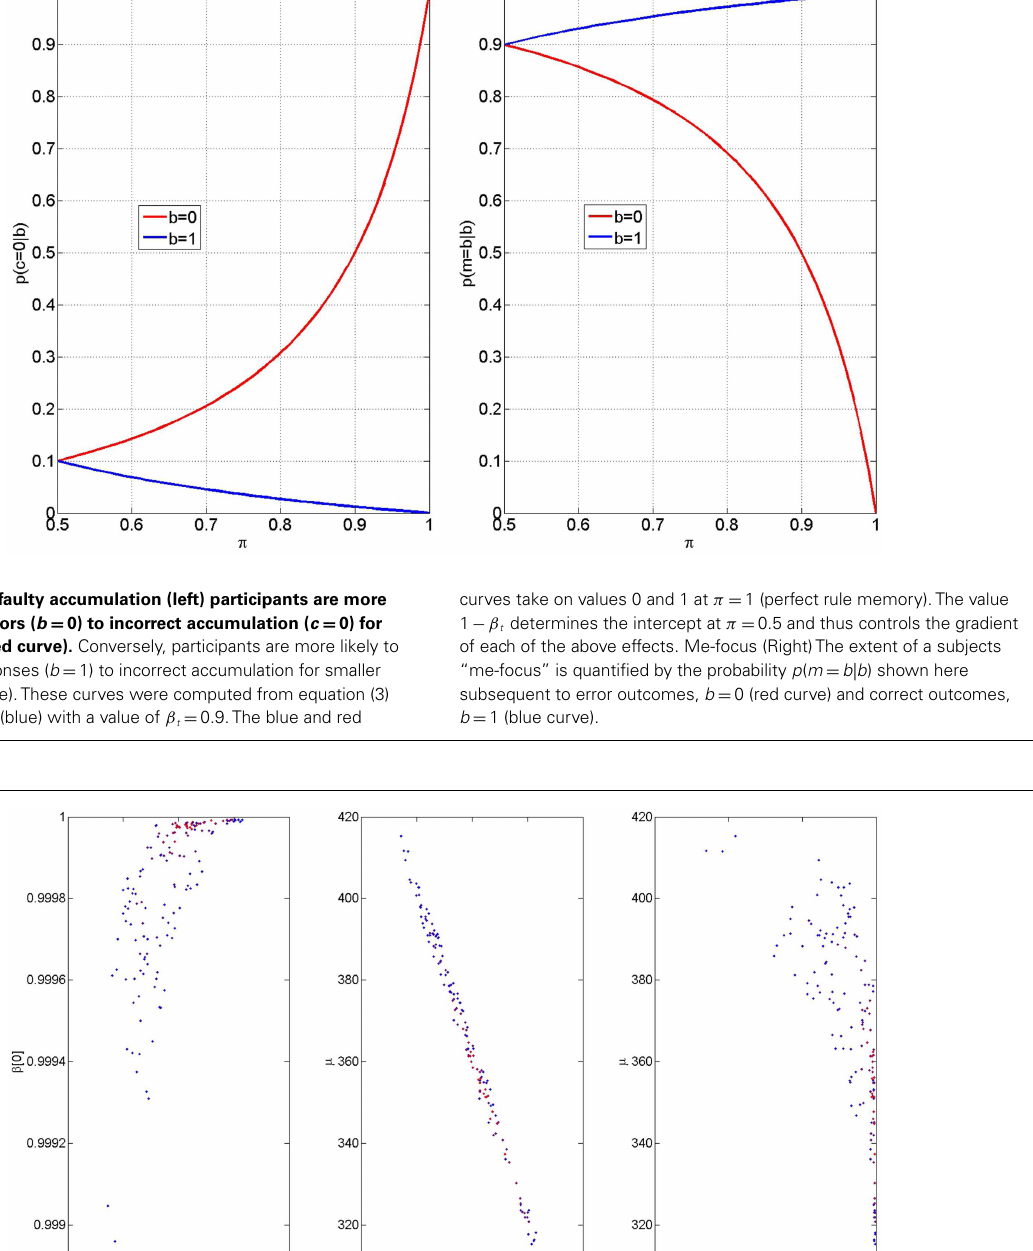
FIGURE 7 | Estimated model parameters from fitting group data. The figures show samples from the bivariate posterior densities p ( β [1], β [0]| b , y ) (left), p ( µ , β [1]| b , y ) (middle), and p ( µ , β [0]| b , y ) (right).The color coding indicates model accuracy, with red indicating a better fit.